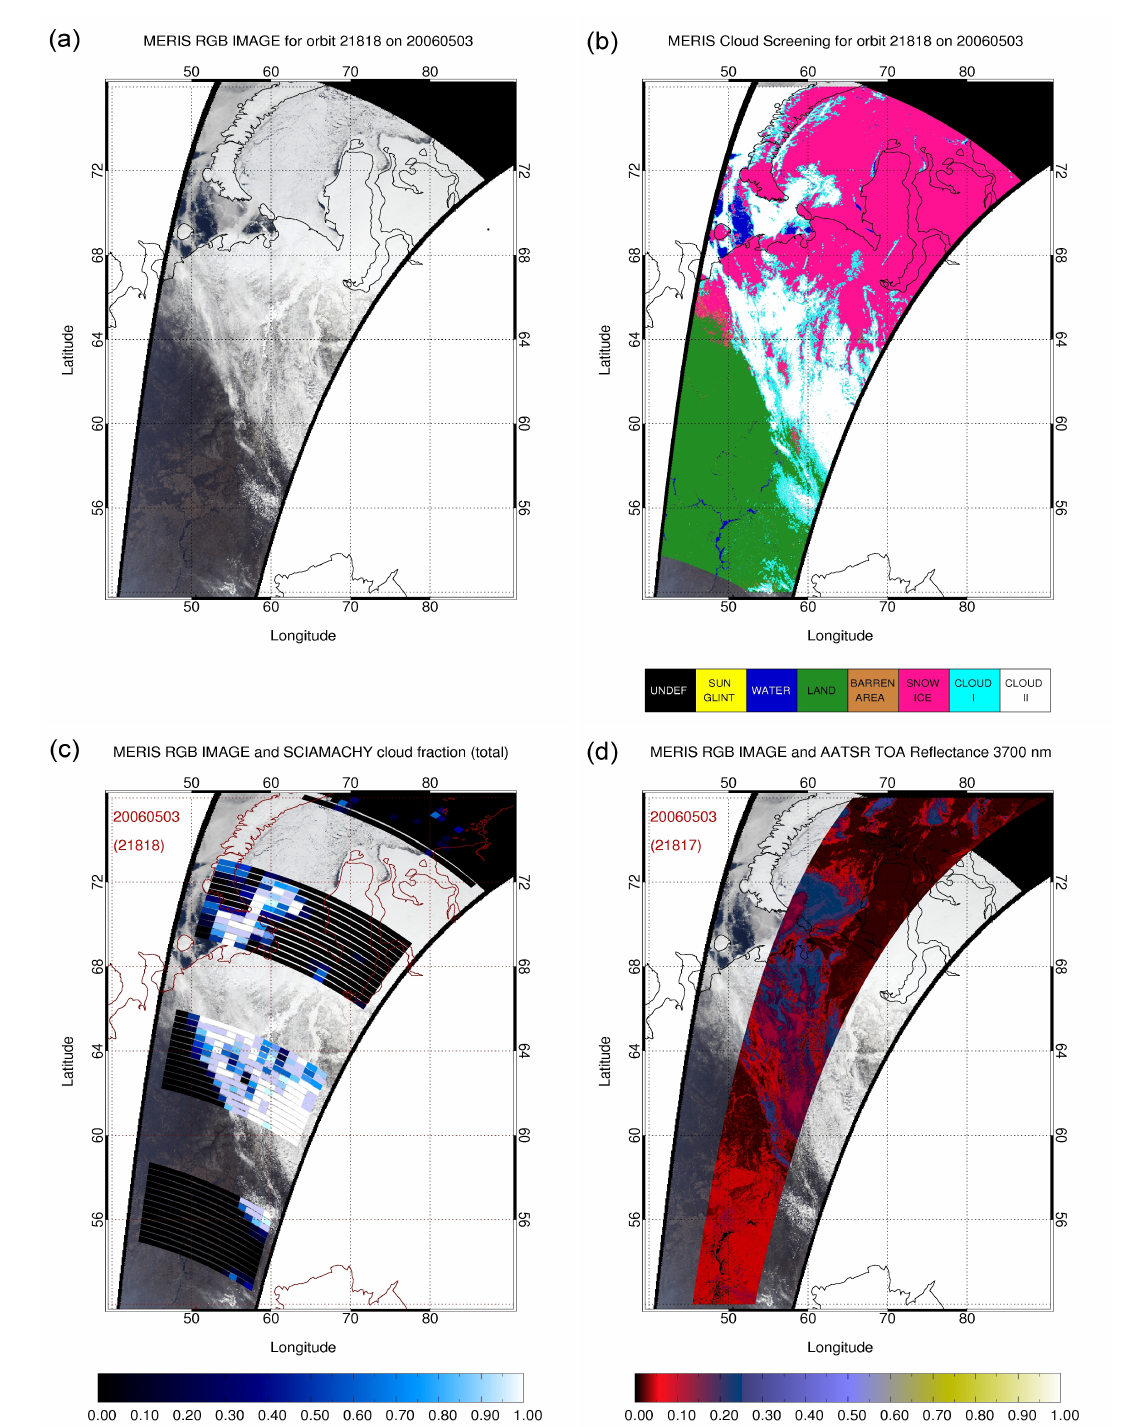
Fig. 6. Maps displaying some part of Russia and the island Novaya Zemlya on the 3rd of May 2006 (orbit 21818): (a) MERIS RGB image, (b) MICROS-MERIS cloud screening, (c) MICROS-SCIAMACHY cloud fraction (at nadir) and (d) top-of-atmosphere reflectance at 3.7 microns measured by AATSR/ENVISAT